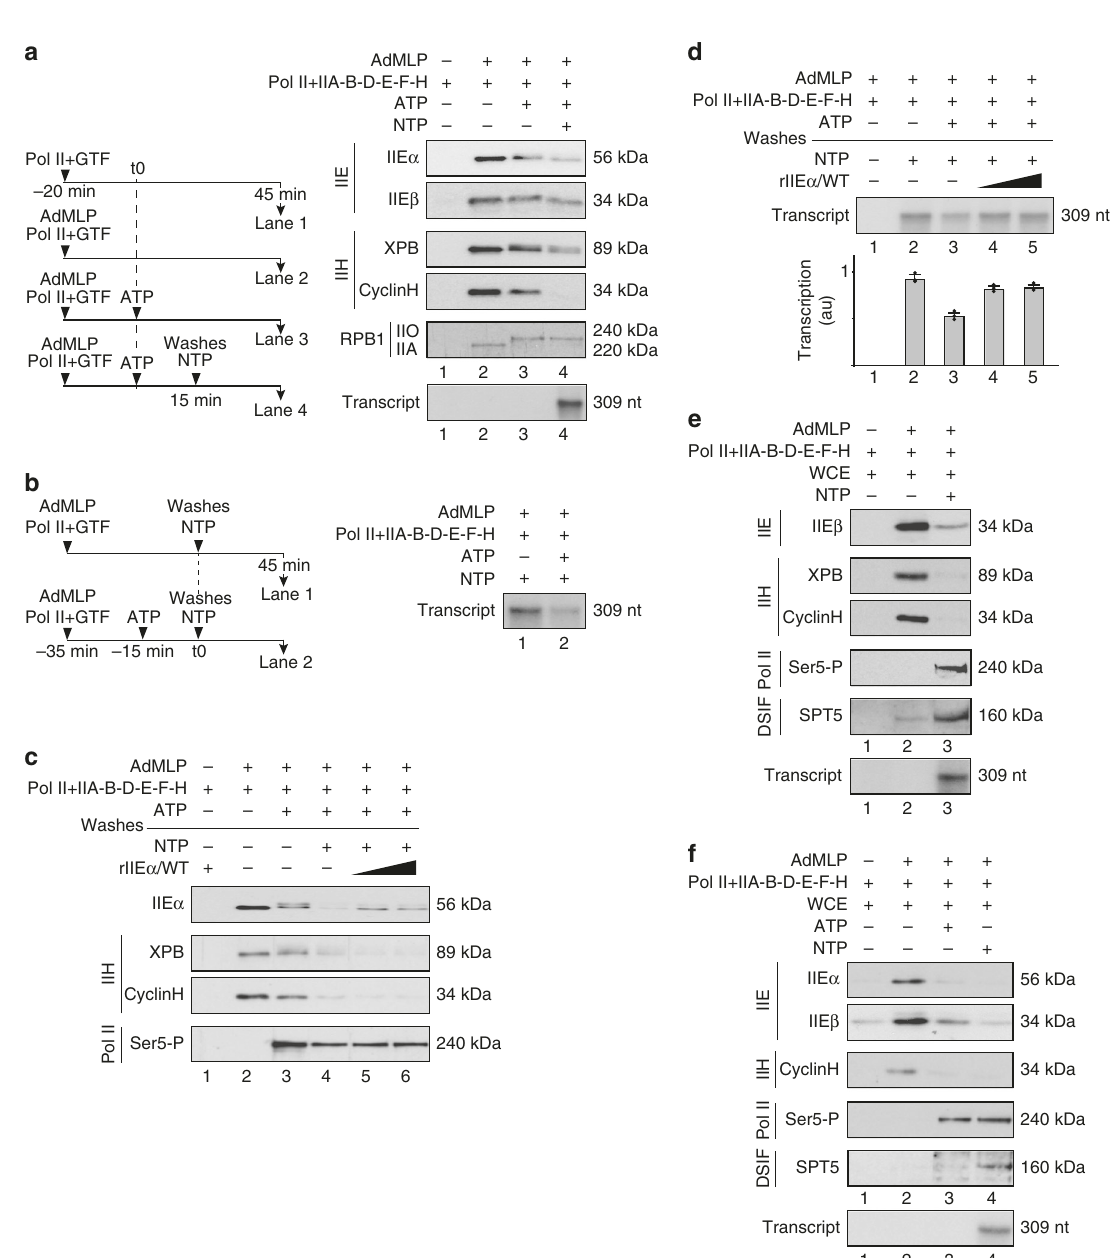
Fig. 5 The CAK is released during RNA synthesis. a Streptavidin magnetic beads were incubated (as depicted in the scheme, left part) with biotinylated AdMLP, Pol II, and the GTFs (TFIIA, TFIIB, TFIID (TBP), rIIE αβ /WT, TFIIF, and TFIIH/WT), in presence of ATP (200 μ M). After 15 min of incubation with ATP, the beads were washed and NTPs (200 μ M) were added (lane 4). Immunoblot analysis (for TFIIE α , TFIIE β , XPB, CyclinH, RPB1) and the transcription activity (309nt run-off transcript) were assessed after 45 min of incubation. The results are representative of three independent experiments. b Streptavidin magnetic beads with biotinylated AdMLP, Pol II, and the GTFs (TFIIA, TFIIB, TFIID (TBP), rIIE αβ /WT, TFIIF, and TFIIH/WT) were pre incubated 15 min (as depicted in the scheme) in presence (lane 2) or absence (lane 1) of ATP (200 μ M). The beads were washed and NTPs (200 μ M) were added. Transcription activity (309nt run-off transcript) were assessed after 45 min of incubation. The results are representative of three